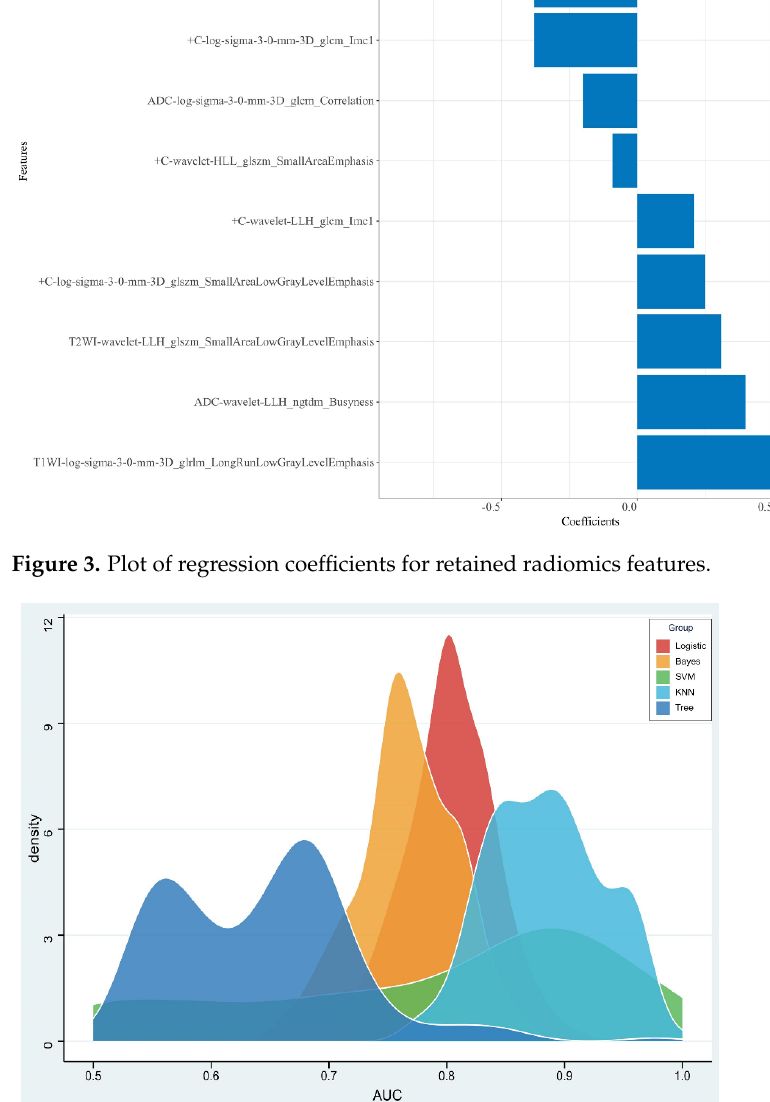
Figure 4. Density distribution of the area under the receiver operating characteristic (AUC) curve of